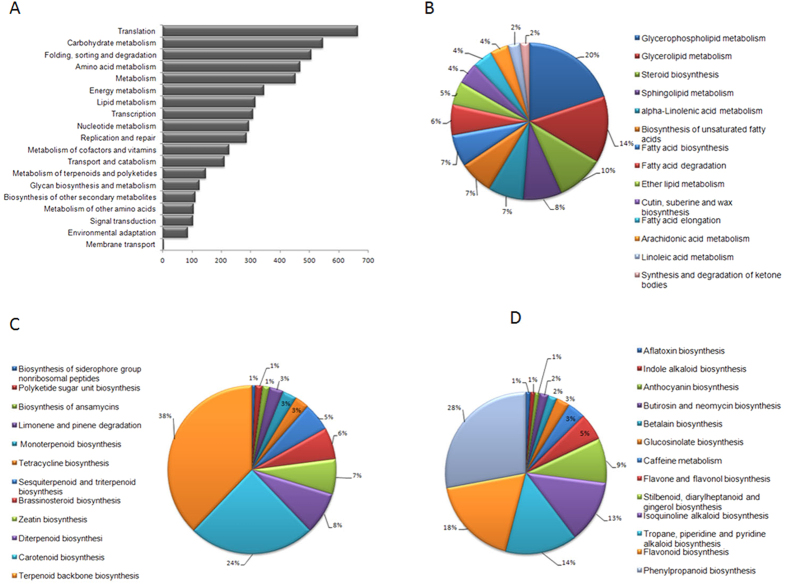
KEGG analysis of C. procera unigenes.(A) Percentage of C. procera unigenes in 19 sub-categories of metabolic pathway category. (B) 13 sub-sub categories of metabolism of terpenoids and polyketides. (C) 12 sub-sub categories of biosynthesis of other secondary metabolites. (D) 14 sub-sub category of Lipid metabolism.